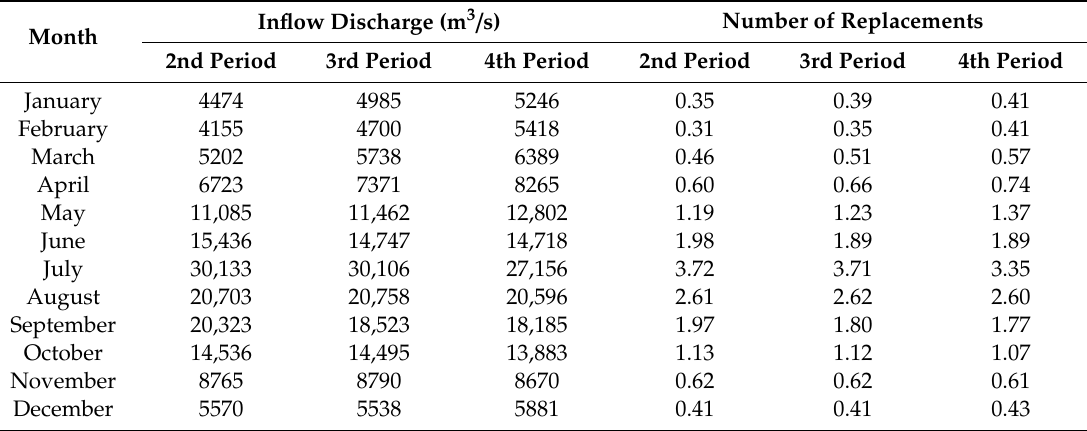
Table 3. Monthly inflow discharge and the number of replacements for the Three Gorges